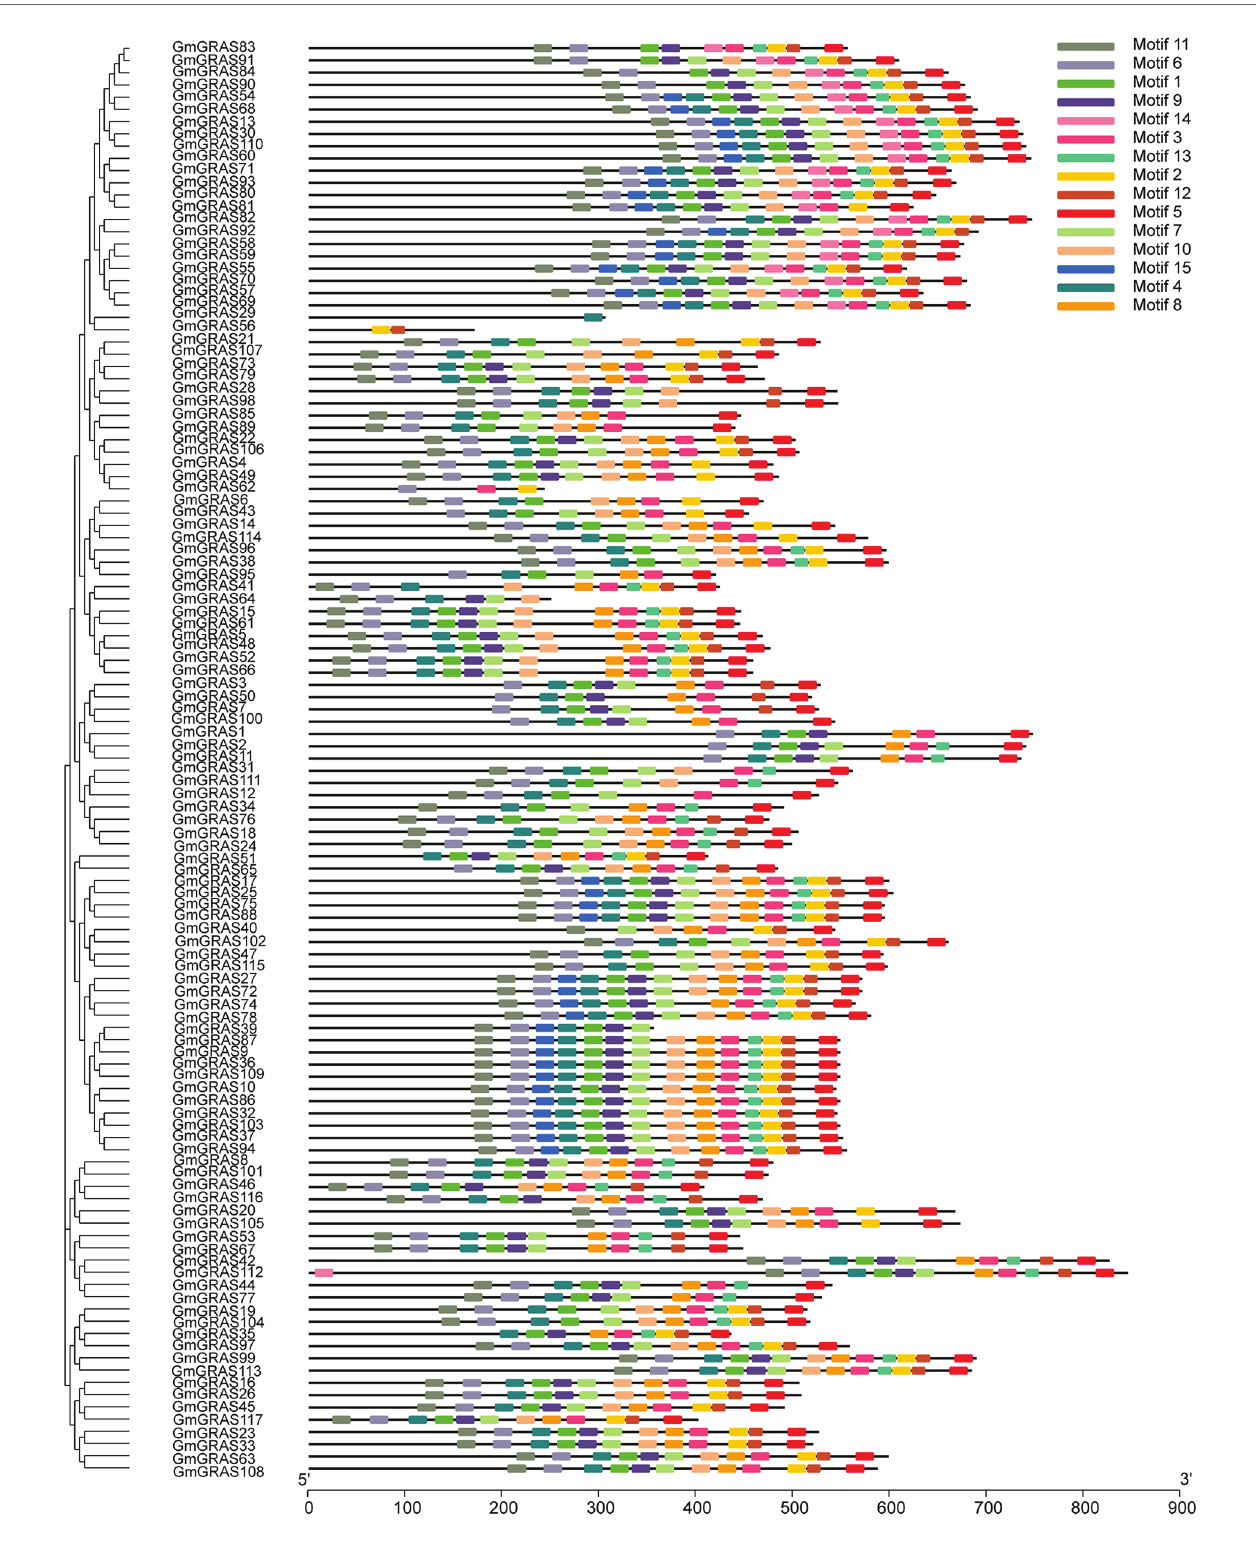
FIGURE 5 | Putative motifs in each GmGRAS protein. Conserved motifs were identified using MEME and TBtools software. Ten putative motifs are indicated by colored boxes. The length of each protein can be estimated using the scale at the